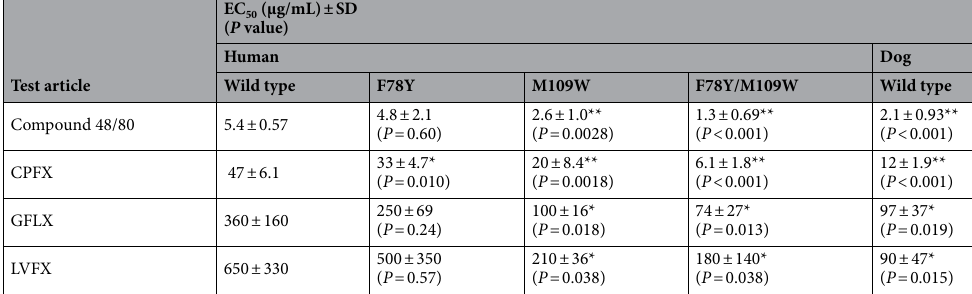
Table 1. Half-maximum effective concentration (EC 50 ) values of test articles on changes in intracellular calcium levels in cells expressing MRGPRX2 or its mutant. Statistical significance was determined by unpaired t-test. Data are represented as mean ± S.D. of quadruplicate assays. CPFX ciprofloxacin, GFLX gatifloxacin, LVFX levofloxacin. * P < 0.05, ** P < 0.01 vs. wild type human